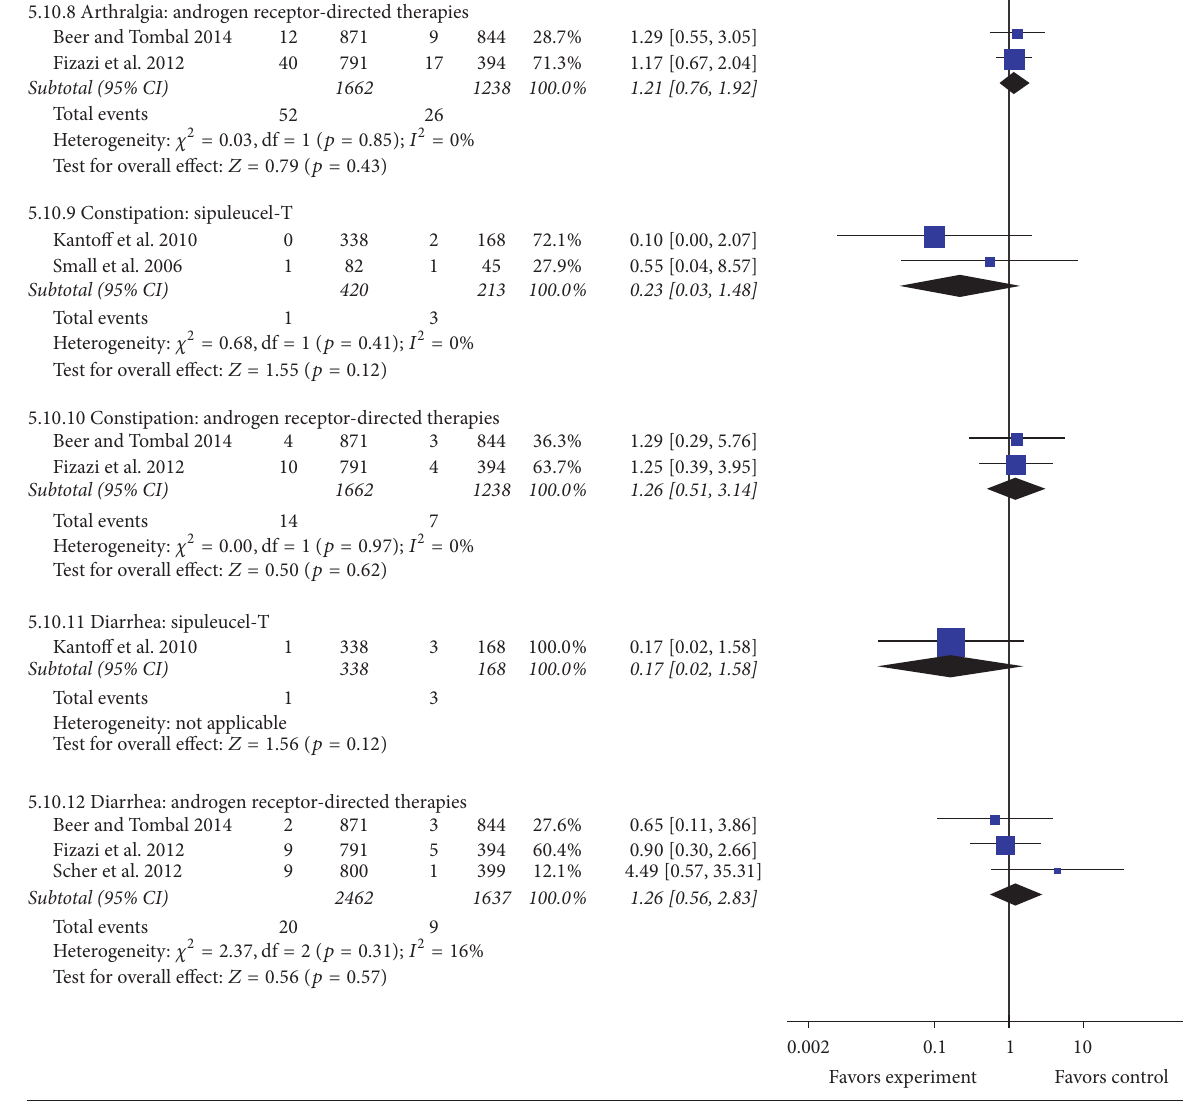
Figure 5: Forest plot of risk ratio of all adverse events of grade ≥ 3 of sipuleucel-T and androgen receptor-directed therapies compared with placeboinmenwithcastration-resistantprostatecancer.Thebarswithsquaresinthemiddlerepresent95%confidenceintervals(95%CIs)and RRs. The central vertical solid line indicates the RRs for null hypothesis. The size of the diamonds represents the weight for the random-effect model in the